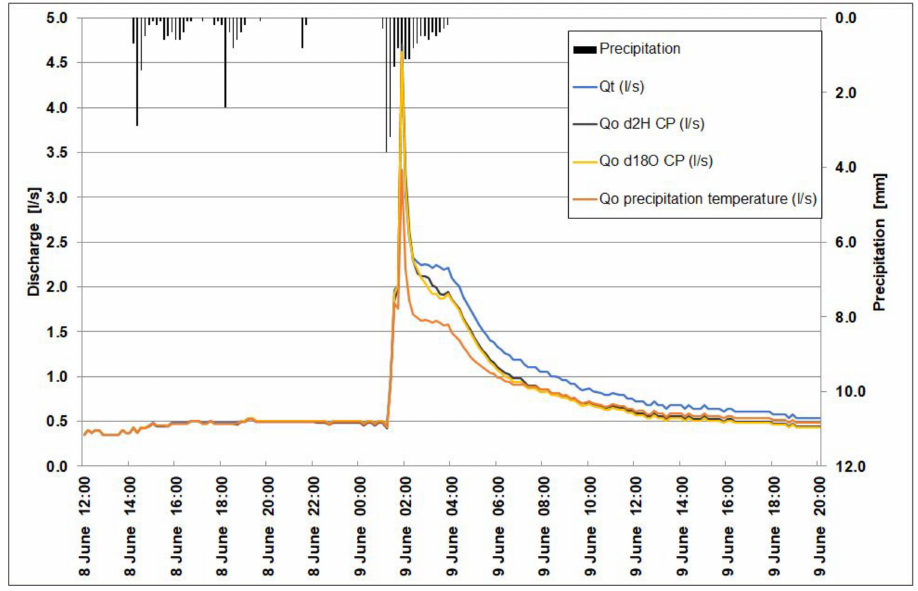
Figure 2. The course of runoff separation based on isotopes of causal precipitation and precipitation temperature in RRE 1-P6 (8 June 2011). Qt, total discharge; Qo d2H, discharge of the old water by separations using δ 2 H values; Qo d18O, discharge of the old water by separations using δ 18 O; Qo precipitation temperature, discharge of the old water by separations using precipitation